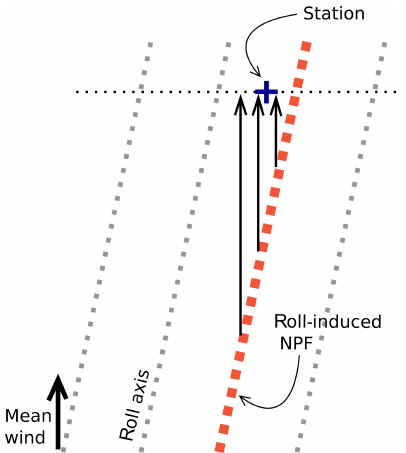
Figure 7. Schematic diagram illustrating how a difference in the direction of the mean wind and the roll axis causes the rolls (and the roll-induced NPF) to move over a stationary point perpendicular to the mean wind